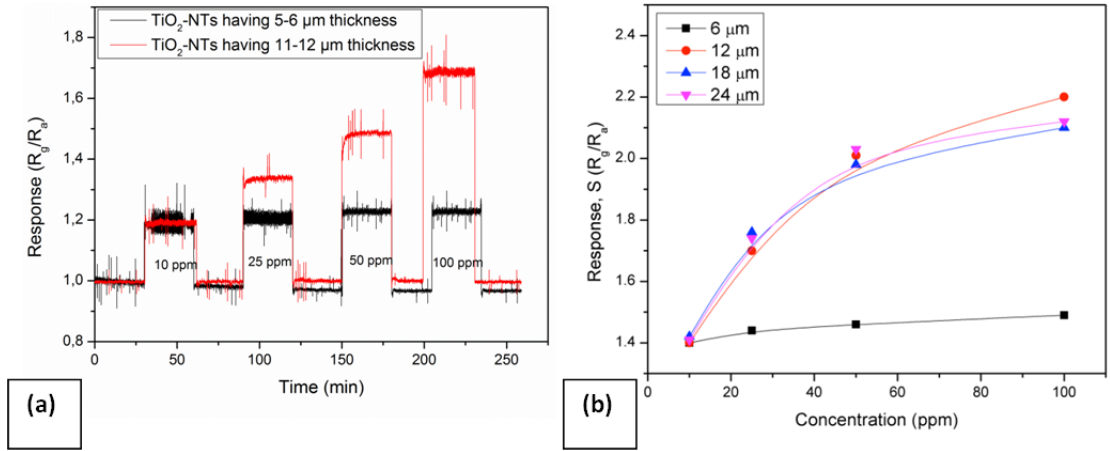
Figure 9. Responses of undoped TiO NTs for different thicknesses at 500 °C towards 2 various NO concentrations ( a ) response versus time ( b ) response versus 2